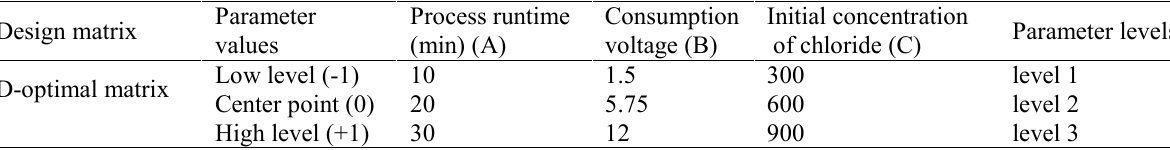
Table 2. Range and levels of independent variables Parameter Design matrix D-optimal